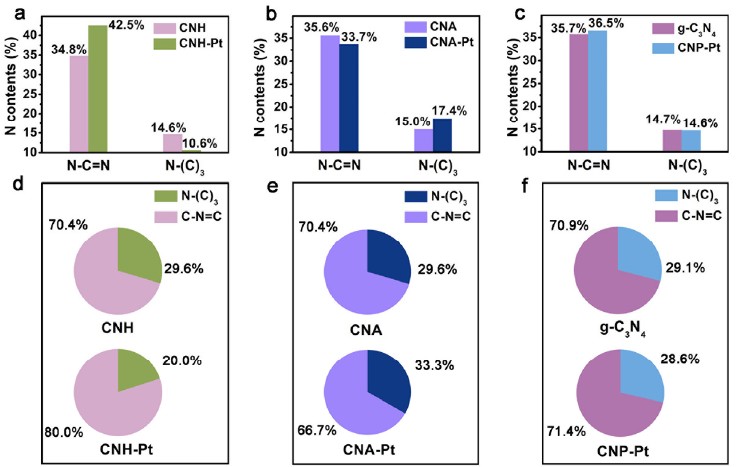
Figure 4. The surface N species content of CNH-Pt and CNH ( a ), CNA-Pt and CNA ( b ), CNP-Pt and g-C 3 N 4 ( c ). The ratio of N-(C) 3 and C-N=C before and after Pt loading of CNH ( d ), CNA ( e ), and g-C 3 N 4 ( f ).